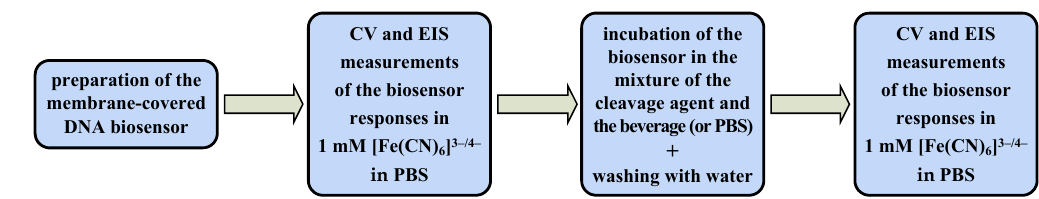
Figure 1. Working procedure used at the evaluation of the antioxidant activity of